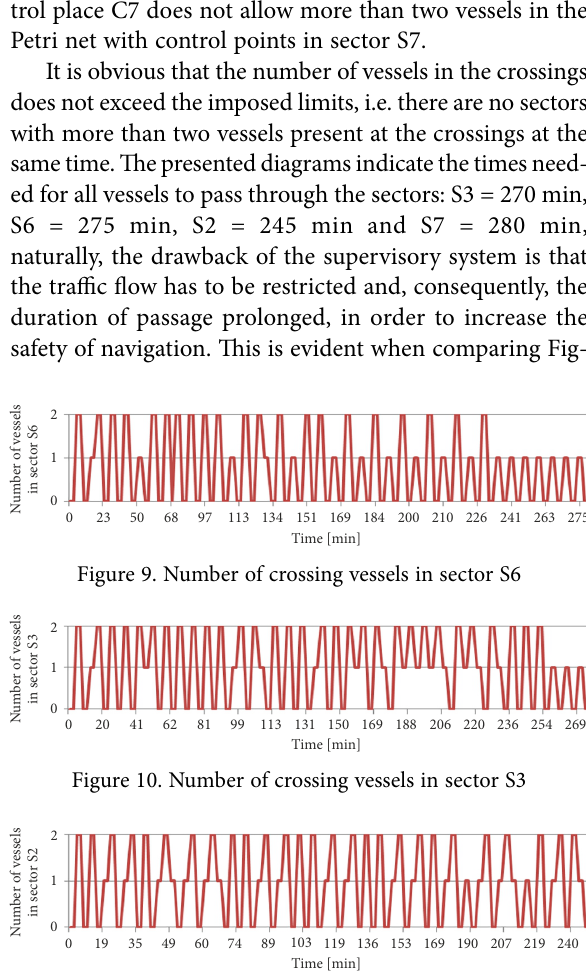
Figure 11. Number of crossing vessels in sector S2